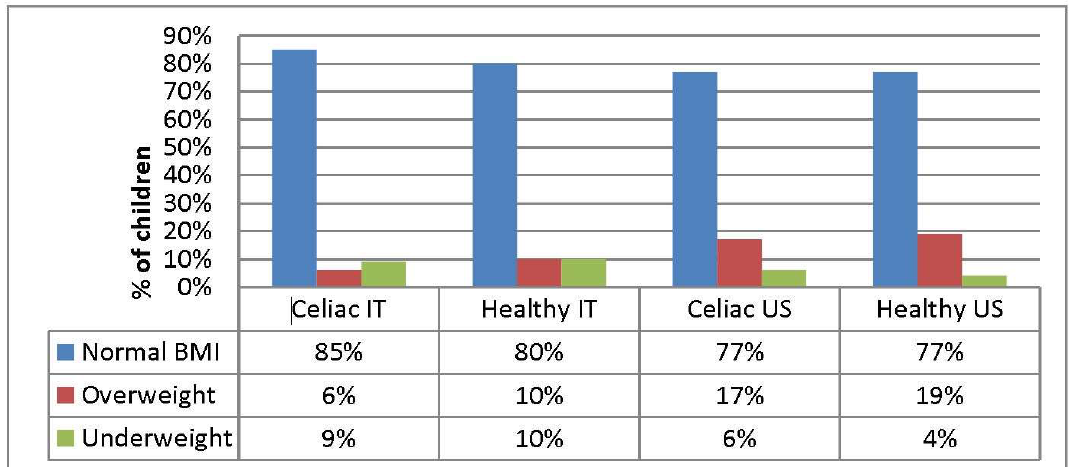
Figure 1. BMI at presentation.